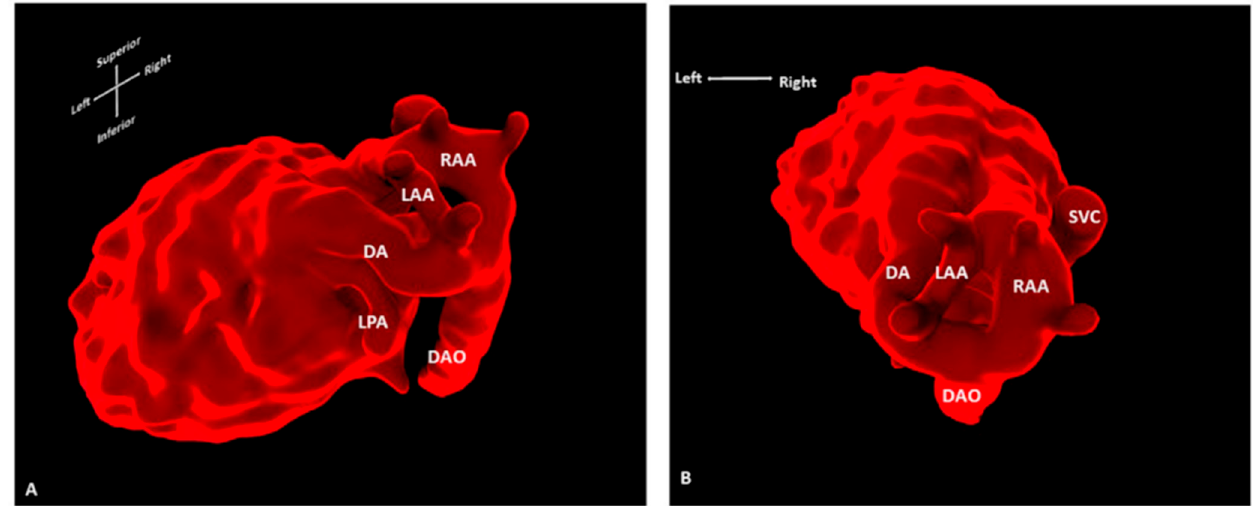
Figure 12. Three-dimensional foetal cardiac MRI showing a double aortic arch. Segmentation of motion-corrected 3D foetal cardiac MRI data, showing ( A ) superior and ( B ) oblique left lateral/superior view of the foetal heart. Foetal cardiac MRI was conducted at 32 + 4 weeks’ gestation for suspected double aortic arch. Surgical findings confirmed the presence of a smaller left aortic arch in addition to dominant right aortic arch and left arterial duct. AD: Arterial duct; DAO: Descending aorta; LAA: Left aortic arch; LPA: Left pulmonary artery; RAA: Right aortic arch; SVC: Superior vena cava.